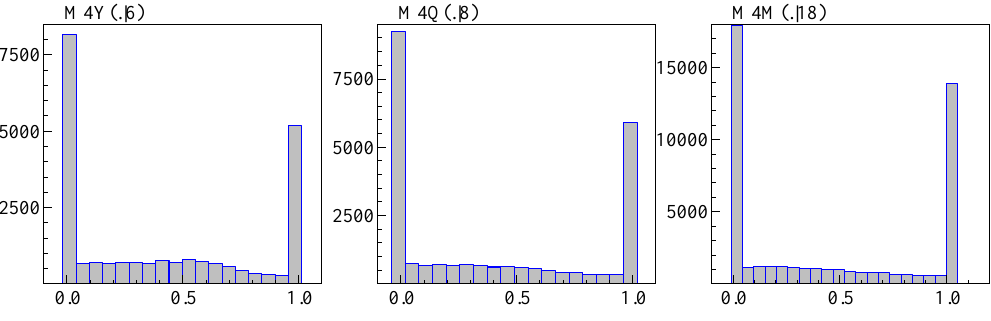
Figure 2. Estimated Box–Cox λ for yearly ( left ), quarterly ( middle ) and monthly M4 ( right ) All observations in M3 and M4 are positive, and experimentation suggests a benefit towards using logarithms.